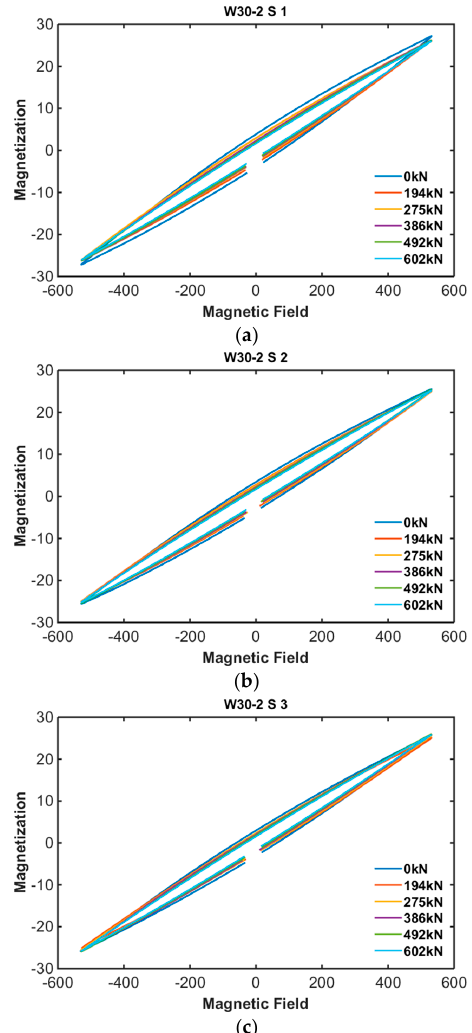
Figure 8 . B-H loop of specimen 2: ( a ) Sensor no. 2-1; ( b ) Sensor no. 2-2; ( c ) Sensor no. 2-3.